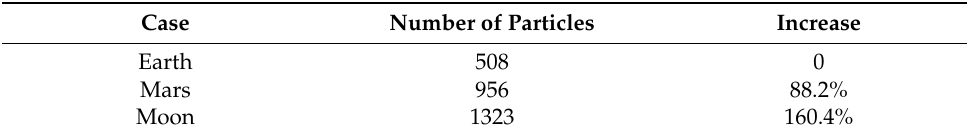
Table 2. Particles lifted during simulation.